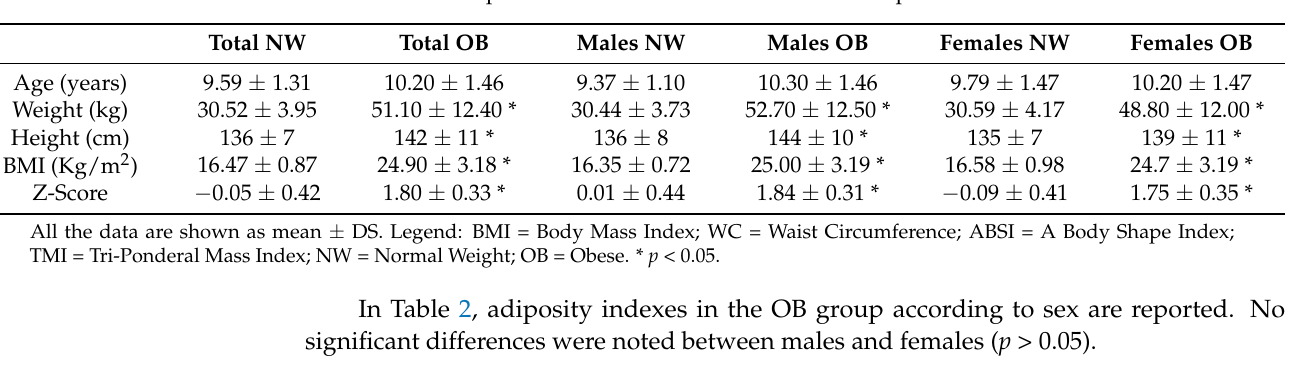
Table 1. Anthropometric characteristics of the whole sample.